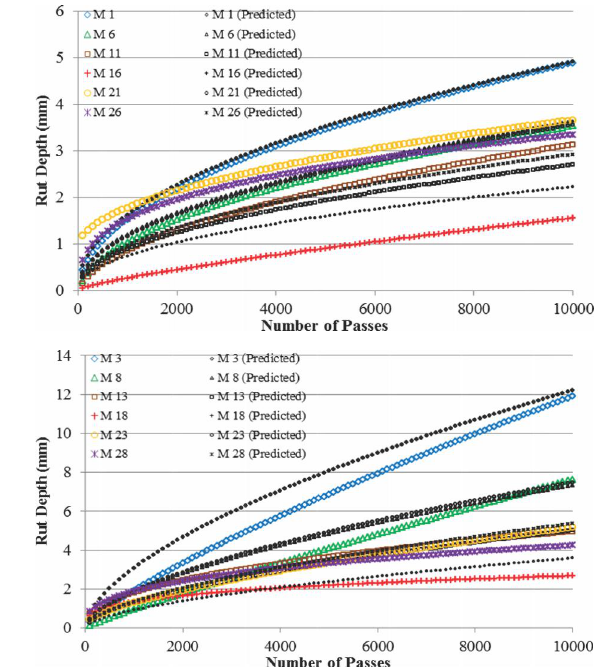
FIG. 8. PREDICTION MODEL VALIDATION USING RUTTING DEVELOPMENT CURVES OF REPRESENTATIVE MIXTURES FOR CWTT (AT 50 O